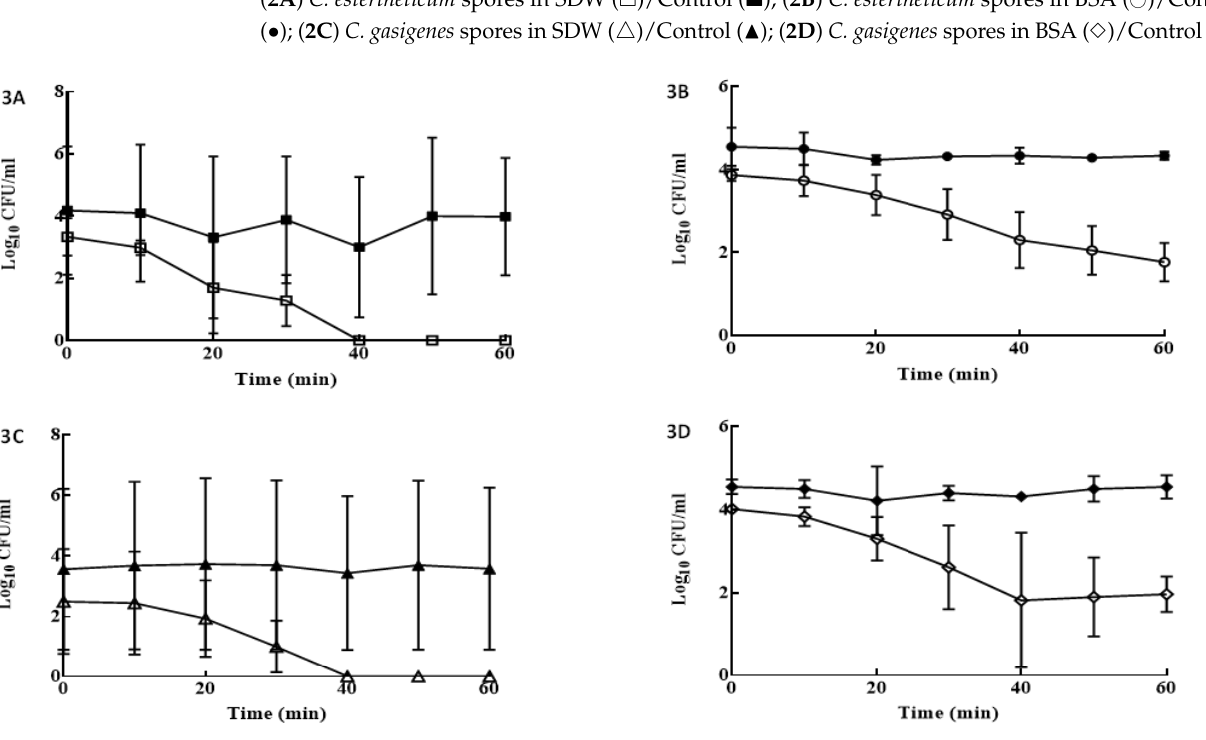
Figure 2. Sporicidal effect of 5% v/v treatment 2 at 0, 10, 20, 30, 40, 50 and 60 min contact times for